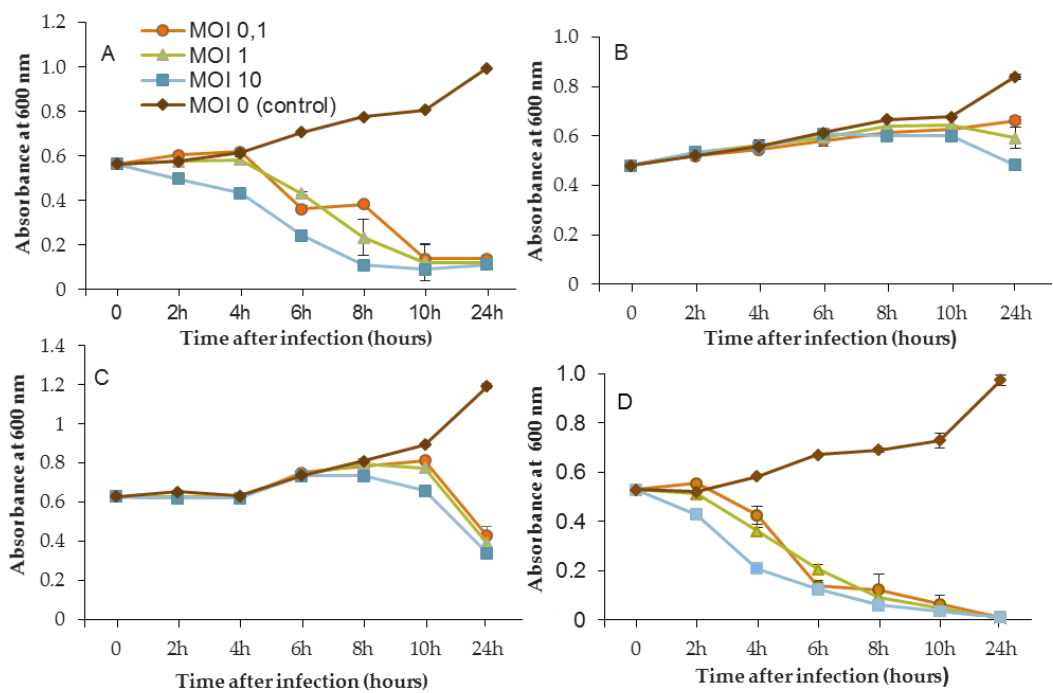
Figure 5. Activity of the phage B1 against planktonic cells of four different P. aeruginosa strains ( A ) D1, ( B ) MLM, ( C ) ST395E, ( D ) PAO1. Each experiment was performed in triplicate, and bars indicate standard deviations. Multiplicity of infection (MOI).